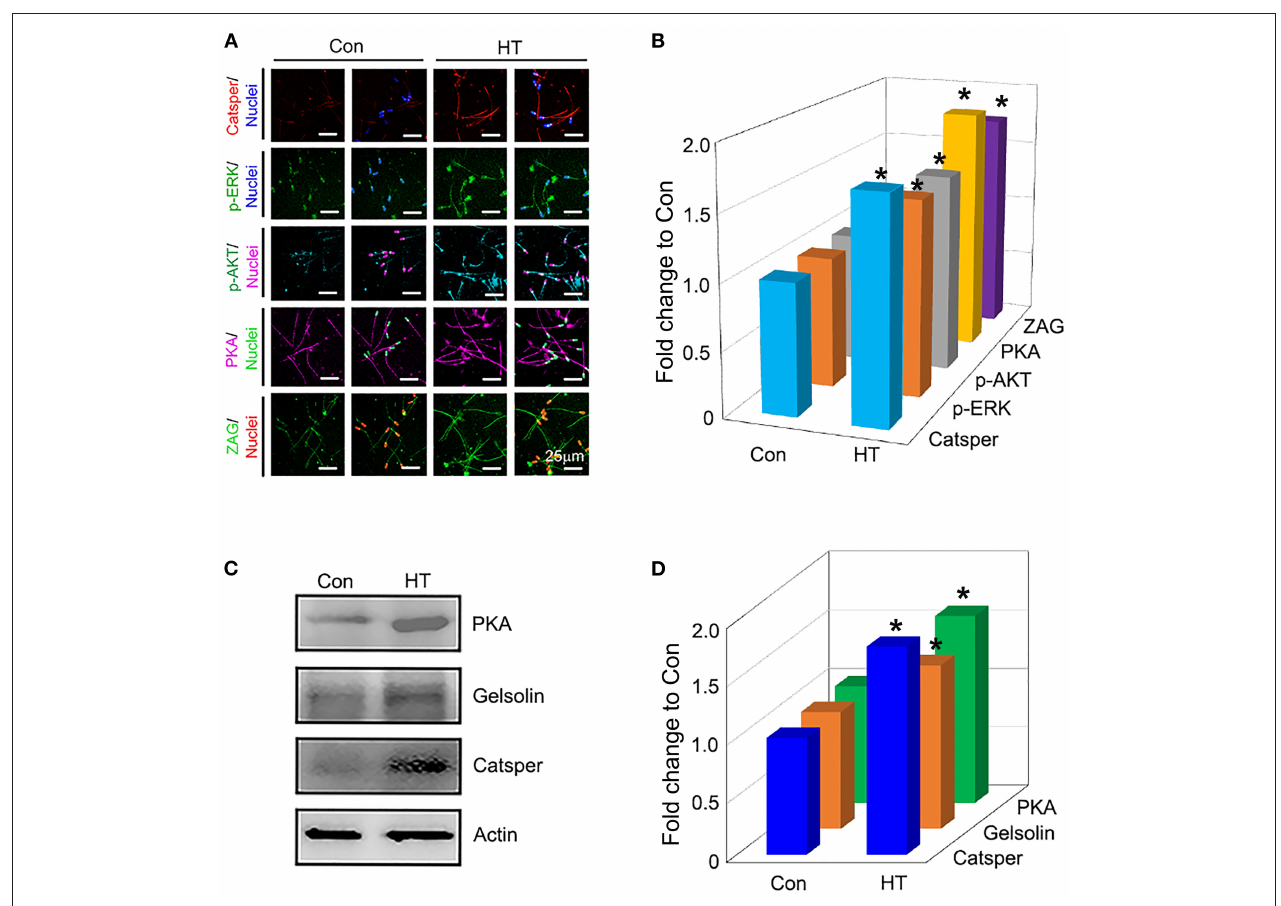
FIGURE 2 | Effects of HT on the protein expression of important genes related to sperm quality. (A) Immunofluorescence staining (IHF) of Catsper, p-ERK, p-ERK, PKA, and ZAG. (B) Quantitative data for IHF staining (Fold change to Con). (C) Western blotting (WB) of PKA, Gelsolin, and Catsper. (D) Quantitative data for WB staining (Fold change to Con). * P <